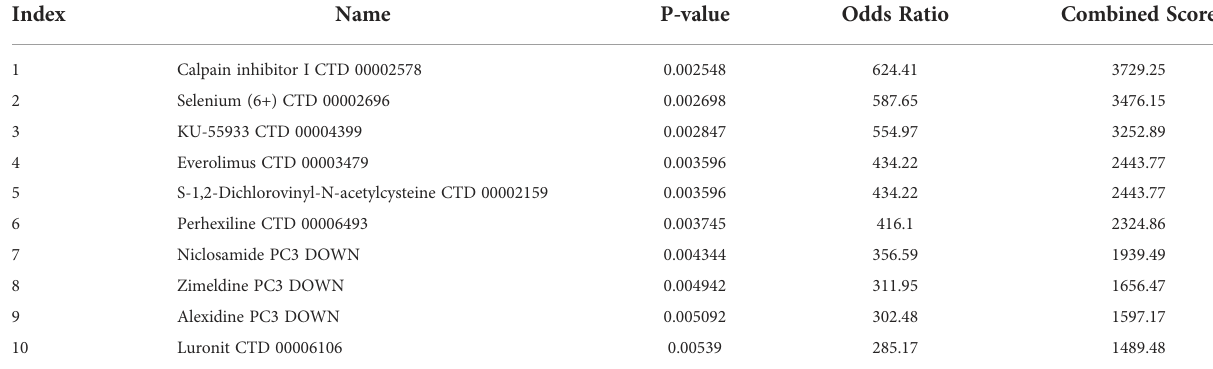
TABLE 1 Evaluation of marketed